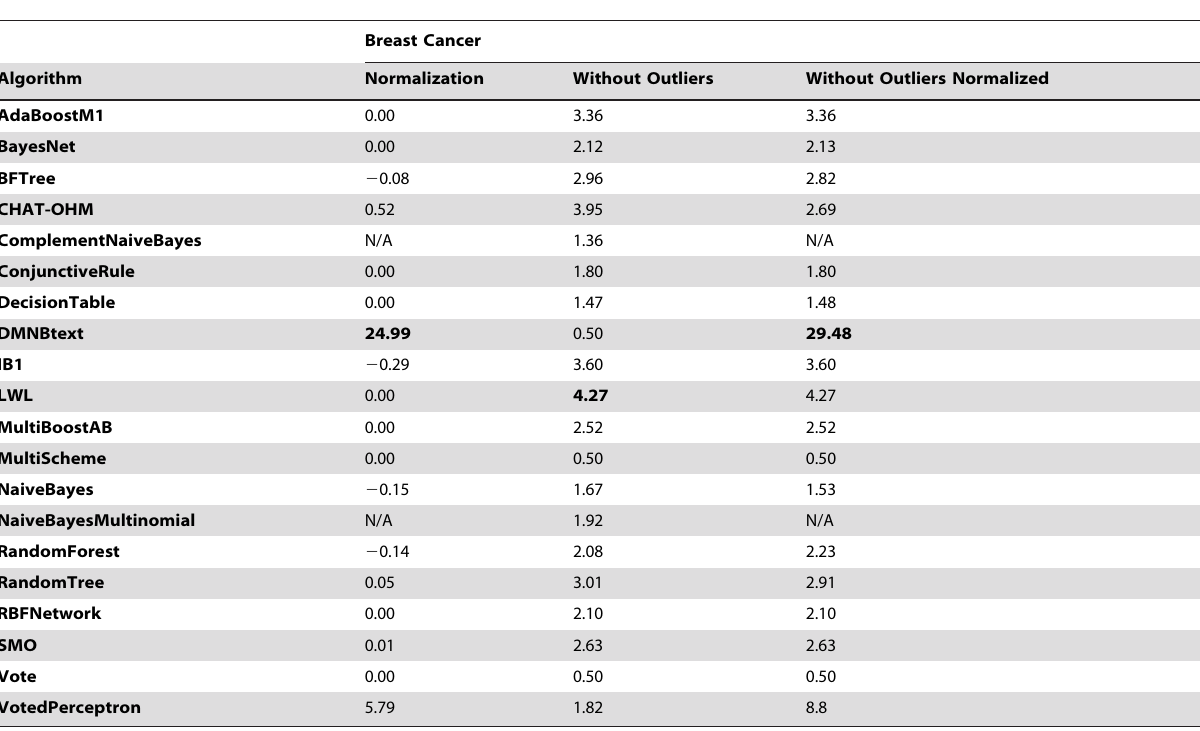
Table 8. Comparison of classification Improvement (%) for Breast Cancer dataset.